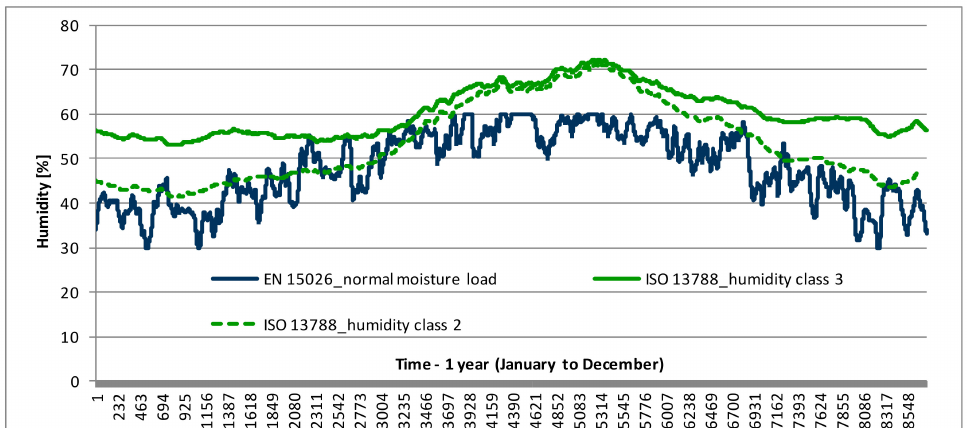
Figure 3. Relative humidity of the indoor air according to standards ISO 13788 and EN 15026.